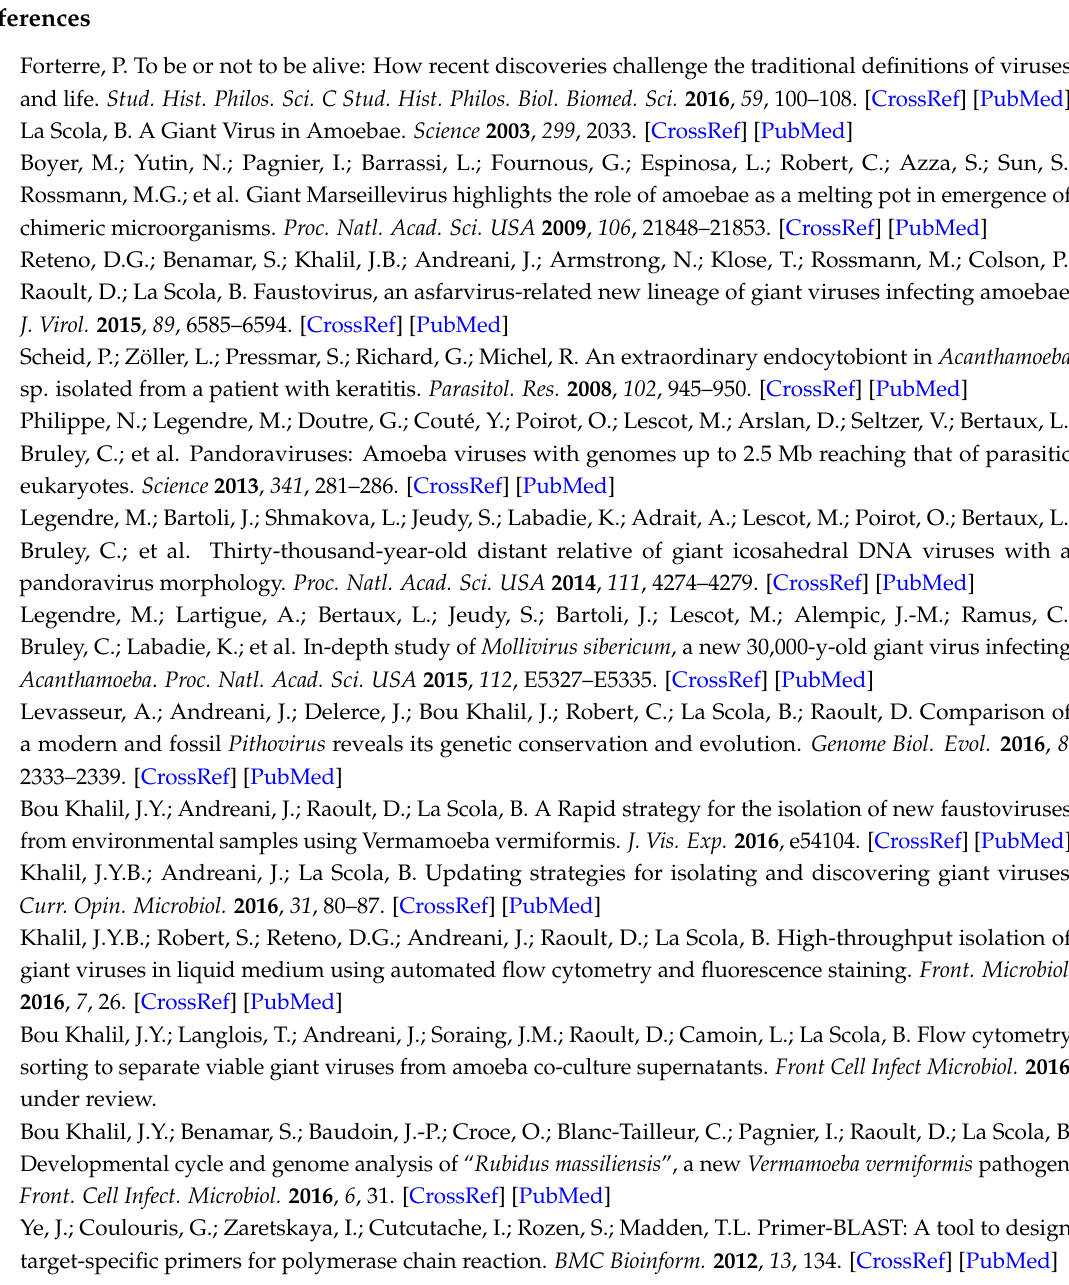
Table S1: Top 12 most represented groups of paralogous genes as determined by the BLASTClust program, Figure S1: Unrooted tree based on family B DNA polymerase amino acid sequences, Figure S2: Unrooted tree based on DNA-dependent RNA polymerase II subunit 2 amino acid sequences, Figure S3: Unrooted tree based on VV-A18 helicase amino-acid sequences, Figure S4: Cladogram based on